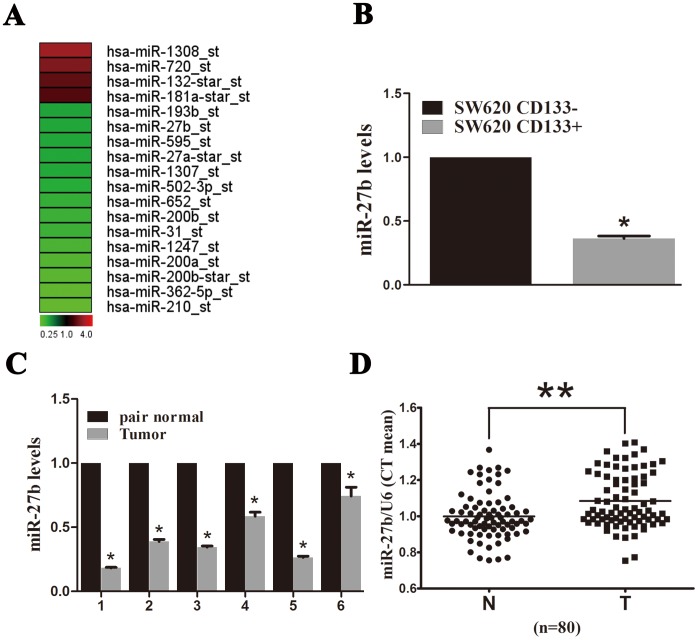
miR-27b expression in cancer stem cells (CSCs) and colorectal cancer (CRC) tumor tissue.(A) Differentially expressed miRNA in CD133+ and CD133− cells. Red denotes high and green denotes low levels of expression. (B) miR-27b expression in CD133+ and CD133− cells was assessed by qPCR. The y-axis indicates fold change. (C) miR-27b expression assessed by qPCR in fresh CRC tissues compared to adjacent normal tissues from six patients. The y-axis indicates fold change. (D) miR-27b expression assessed by qPCR in 80 paired paraffin-embedded CRC and adjacent normal tissues. miR-27b levels were normalized to U6 and expressed in terms of the threshold cycle (Ct) ratio. Error bars represent the means ± SEM, *P<0.05, **P<0.01.